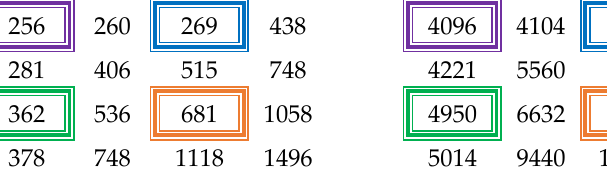
Figure 3. Summed-area tables for higher powers: ( left ) 2nd, ( middle ) 3rd, ( right ) 4th.